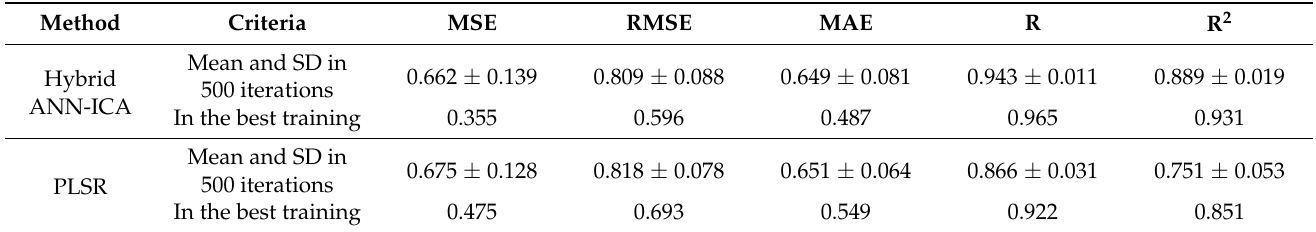
Table 4. Comparison of various criteria evaluating the efficiency of ANN-ICA and PLSR for predicting BrimA in 500 replications using spectral data of effective wavelengths.